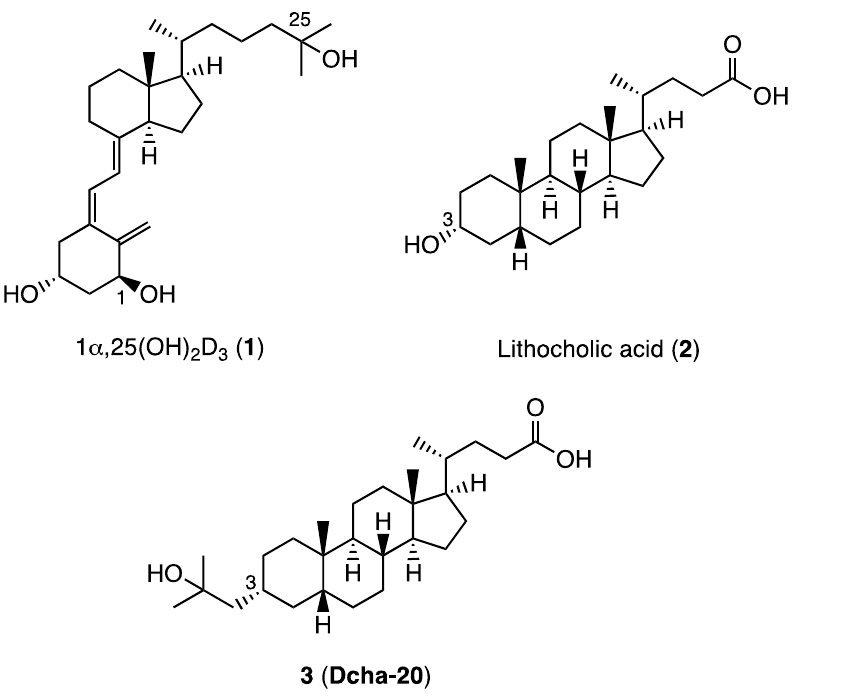
Figure 1. Structures of 1 α ,25(OH) 2 D 3 ( 1 ), lithocholic acid (LCA, ( 2 ), and lithocholic acid derivative ( 3 ) ( Dcha-20 ).